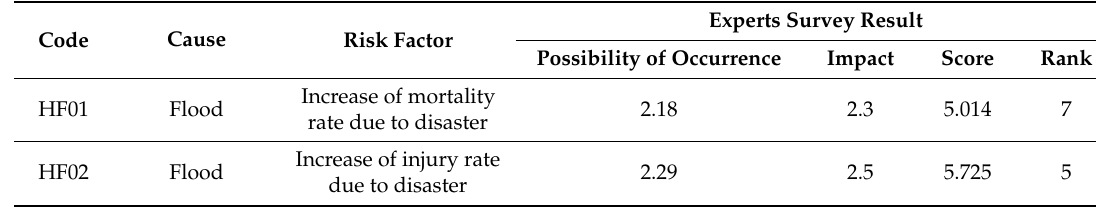
Table A6. HF risk factors and assessment result of